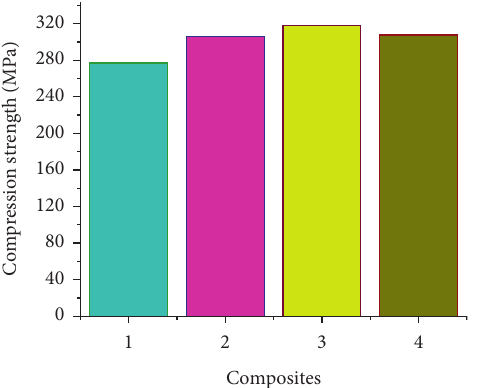
Figure 6: Compression strength of the developed composites. (1) Mg alloy; (2) coated Al 2 O 3 ; (3) coated SiC; (4) coated Al 2 O 3 +SiC.